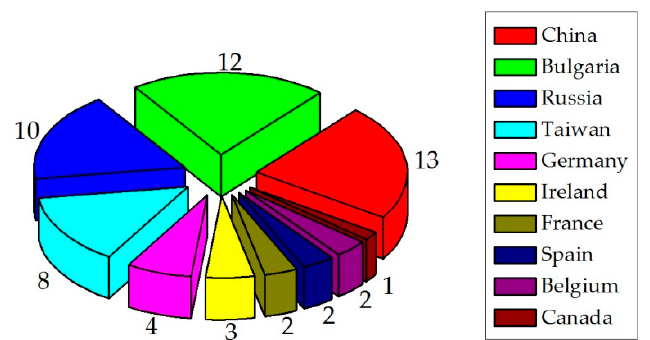
Figure 1. Geographic distribution by the country of authors.